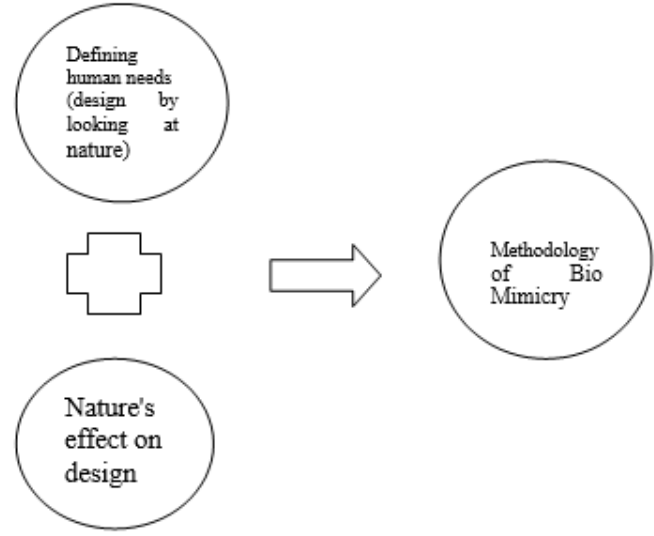
Figure 3. a diagram shows bio mimetic approach categorized in two categories: design by looking at nature and nature influence on design. Source: the